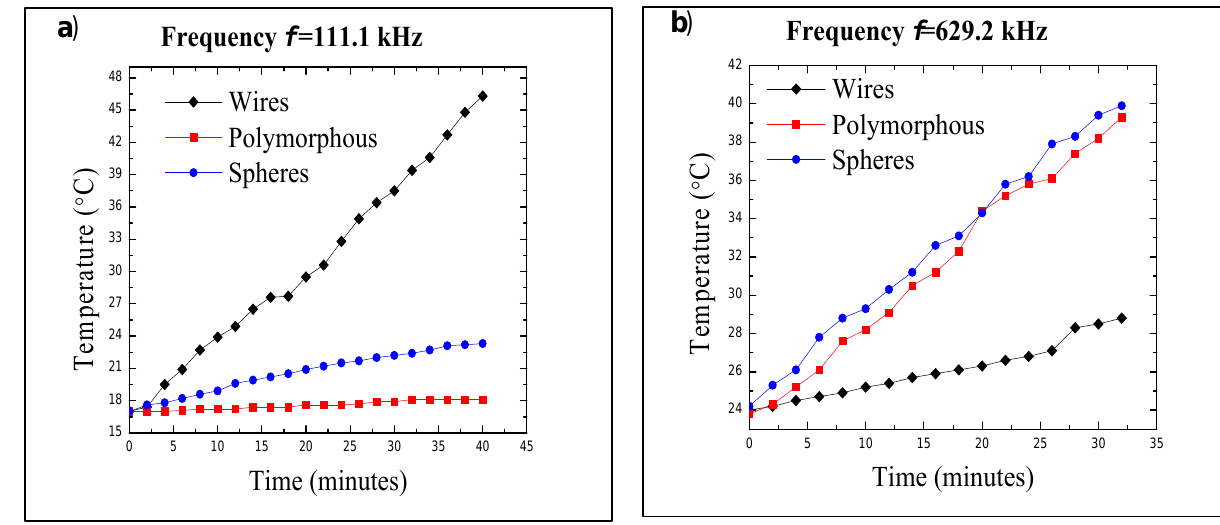
Figure 7. Hyperthermia data comparing the frequency dependence for different nanocrystal morphologies (22 nm spheres, polymorphous nanocrystals, and 55 × 2 nm wires). Taken at frequency of ( a ) 111.1 kHz (magnetic field 25 mT) and ( b ) of 629.2 kHz (magnetic field 9